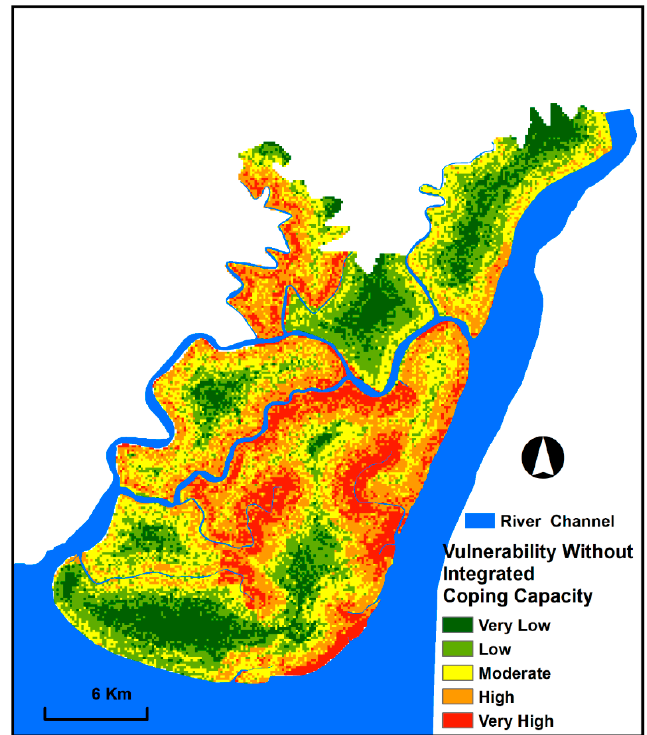
Figure 9. Vulnerability map without integrated coping capacity exhibiting spatial patterns and the degree of vulnerability to floods.